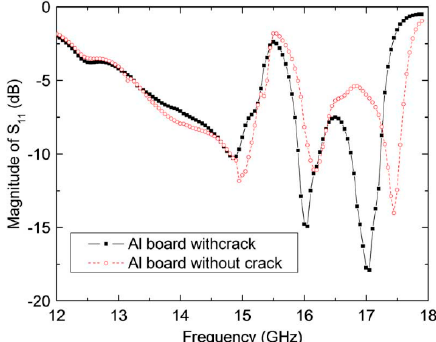
Figure 22. Re fl ection coef fi cient of the probe with and without a crack. The width and depth of the crack are 0.3 and 2 mm, respectively. The standoff distance between the PCB and the aluminum surface is 0.6 mm in both cases (from [40]; copyright © IEEE 2014; reproduced with permission).